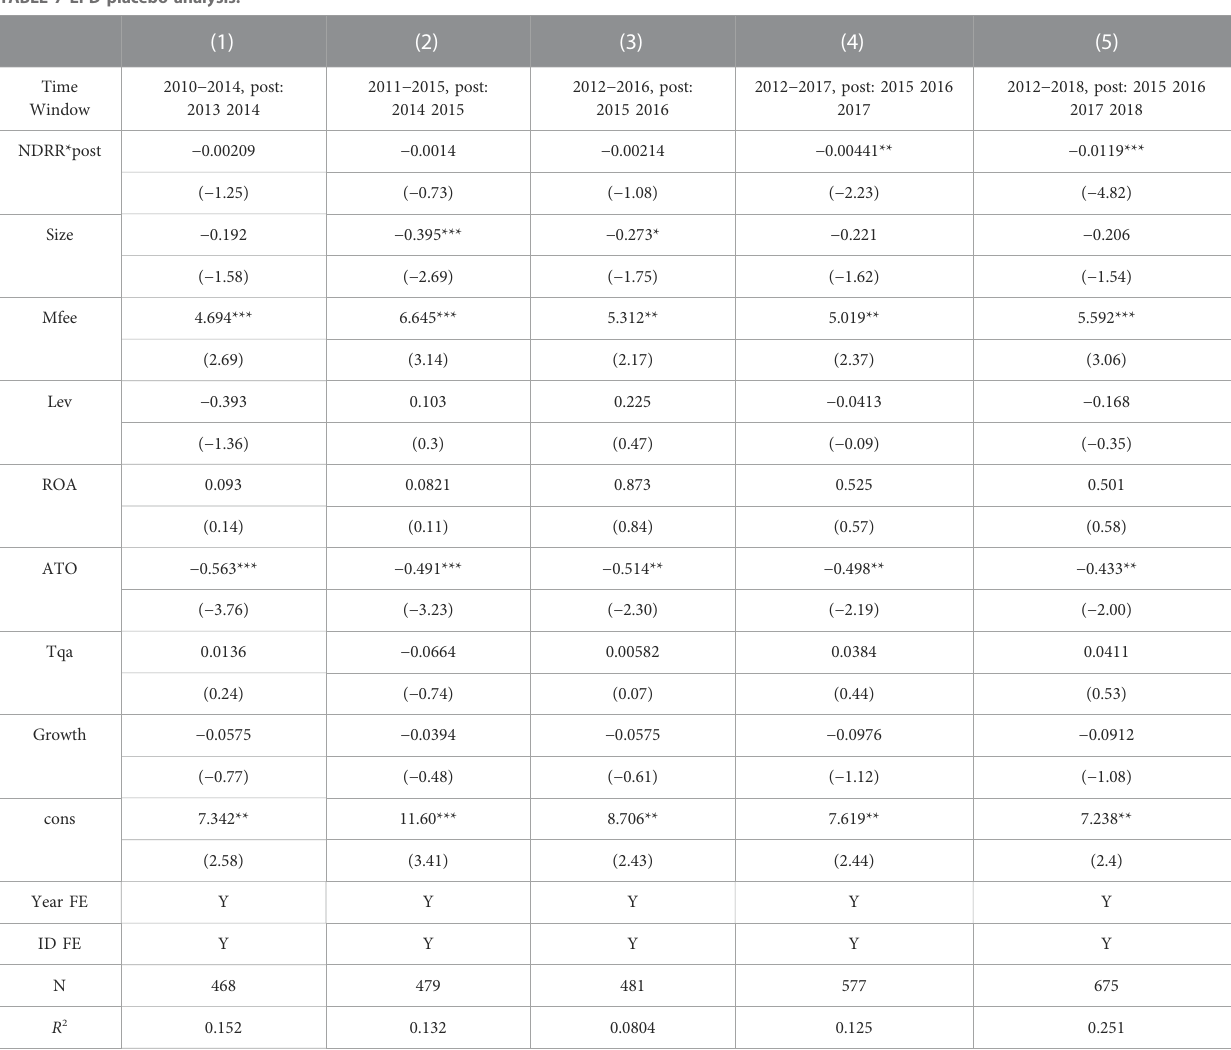
TABLE 7 EPD placebo